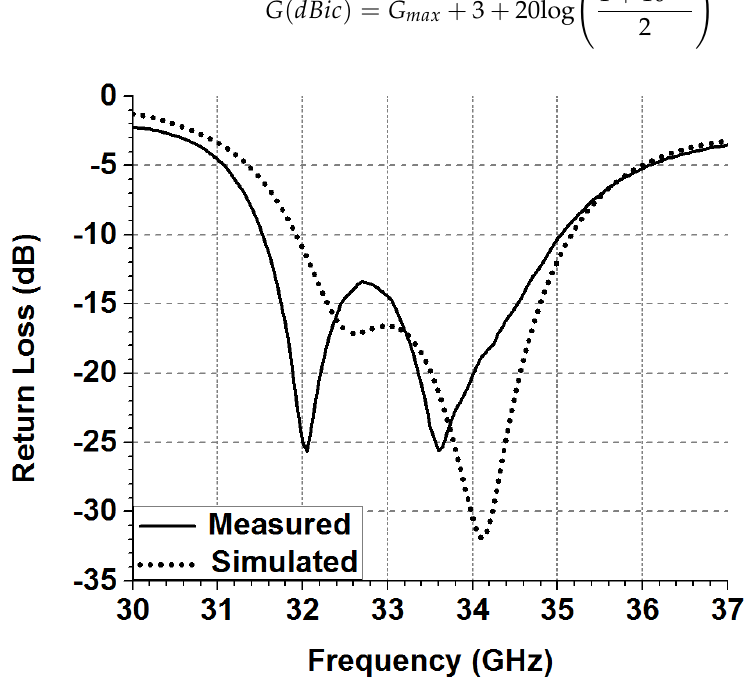
Figure 6. The simulated and the measured return-loss performance graph of the designed antenna.